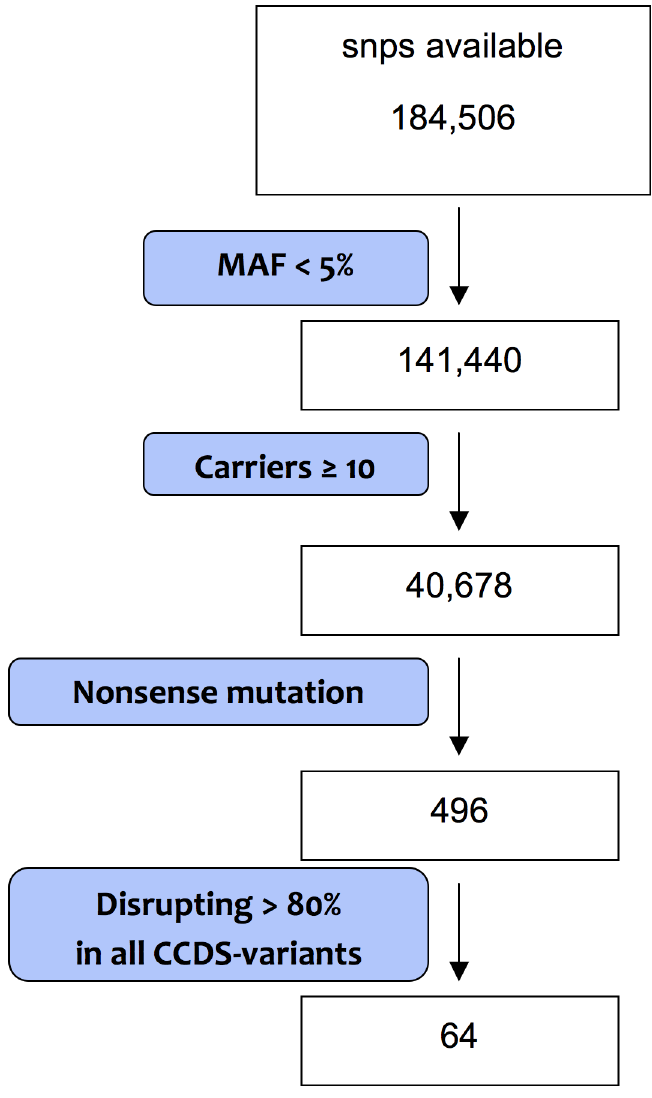
Fig 1. Selection of snps. Numbers indicated number of snp available in each step. Detailed selection criteria can be found in the methods section.